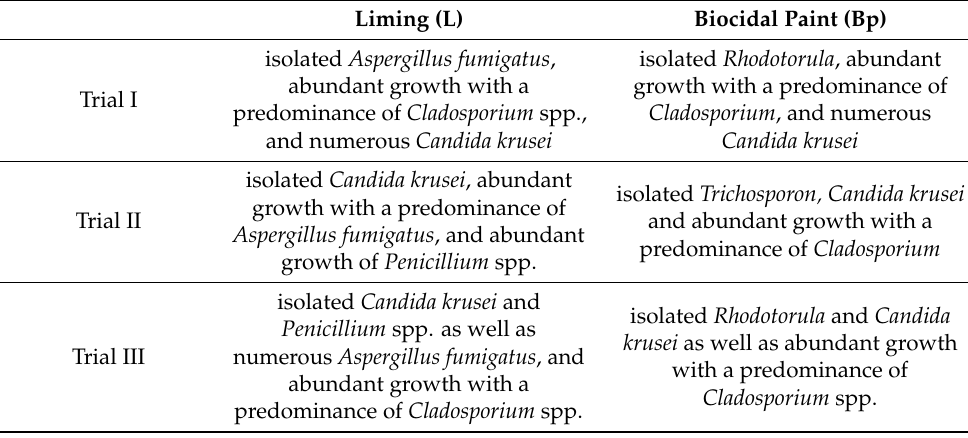
Table 8. Bacterial genera/species identified in